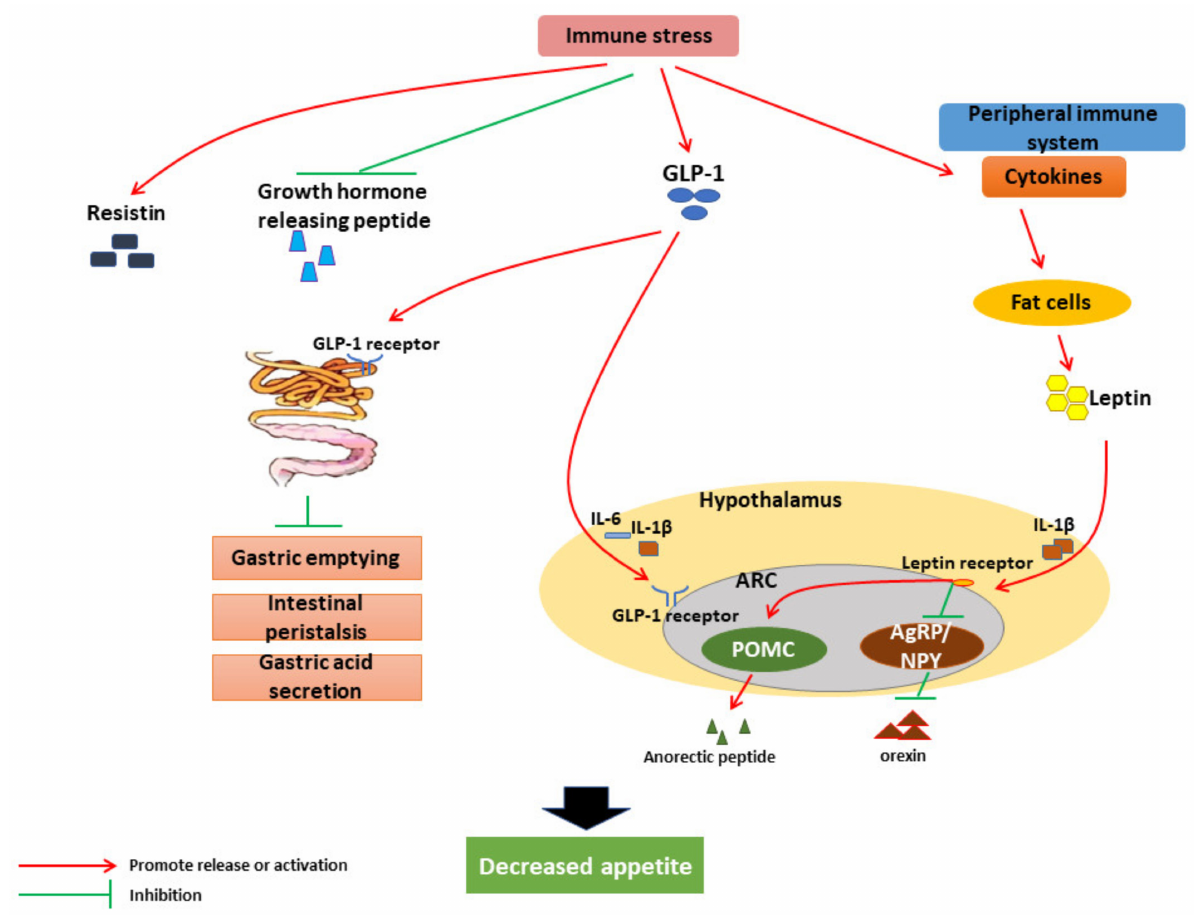
Figure 2. Mechanism of appetite suppression by